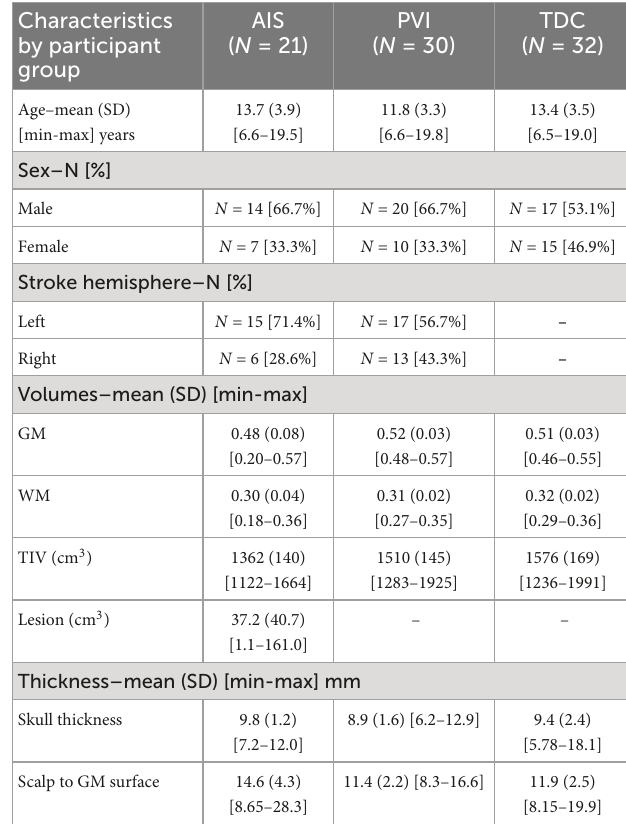
TABLE 1 Demographic and anatomical characteristics of participant